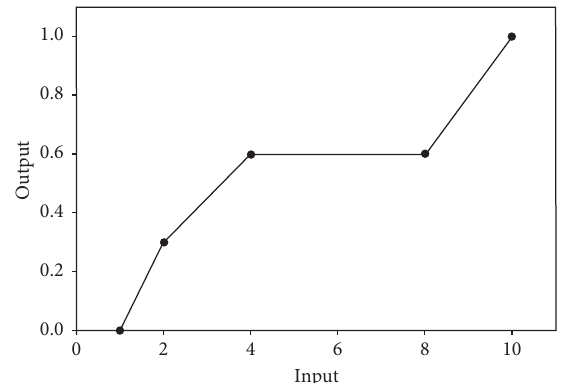
Figure 5: Illustration of an LUT with 5 control points. The x -axis presents the input value of the LUT, and the y -axis presents the output value of the LUT. The entire line presents the input-output relationship of the LUT, in which dark-gray points present control